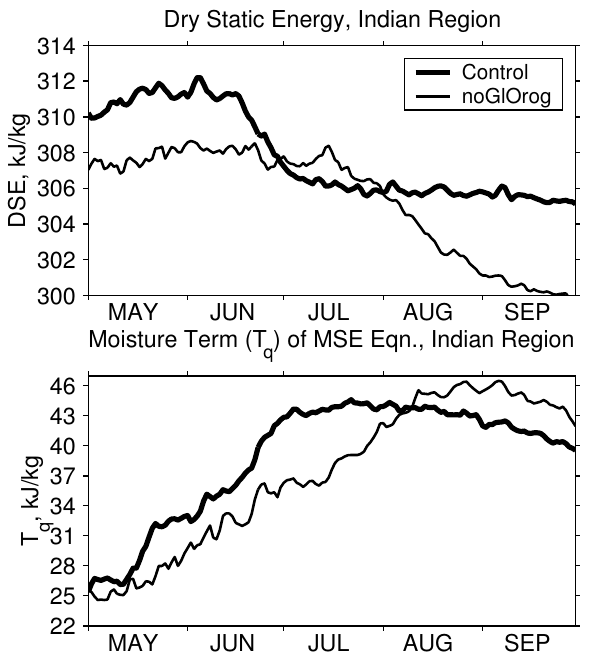
Fig. 5. Surface dry static energy (DSE) and moisture term of the moist static energy equation (T q ) over the Indian region from the control and noGlOrog